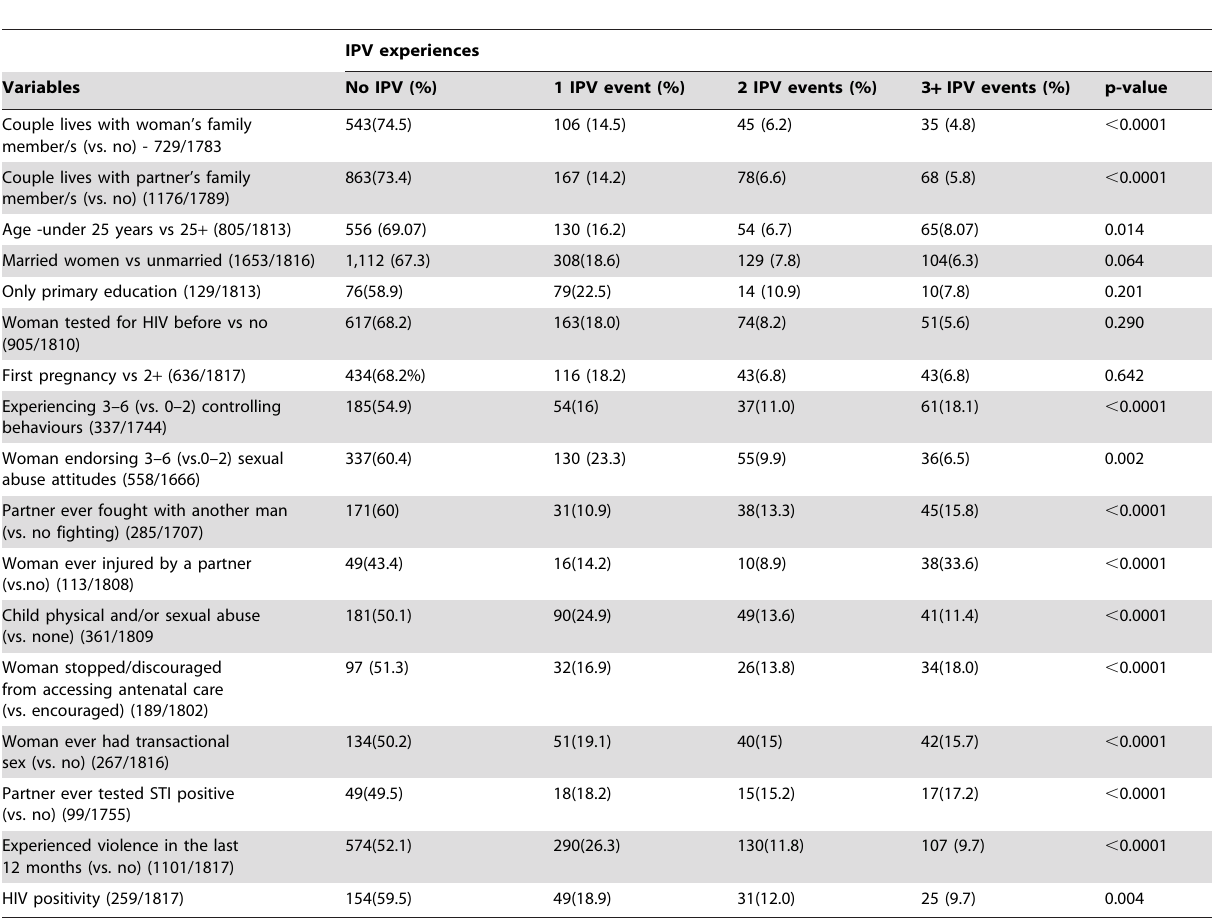
Table 2. Characteristics of participants by experiences of physical, sexual and/or emotional intimate partner violence after HIV disclosure.